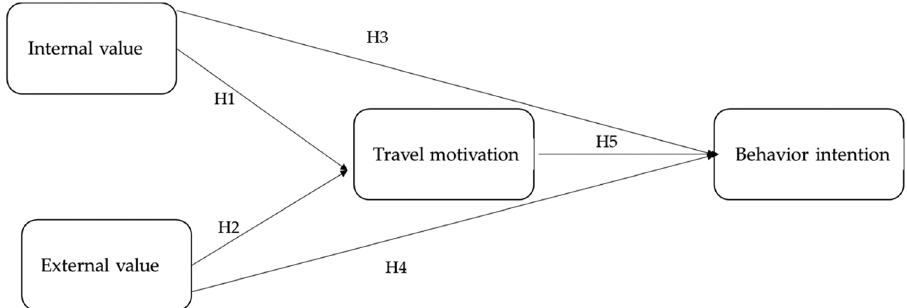
Fig. 1 Female solo travel intention research model. The model examines the relationship between internal values, external values, travel motivation and behavioral